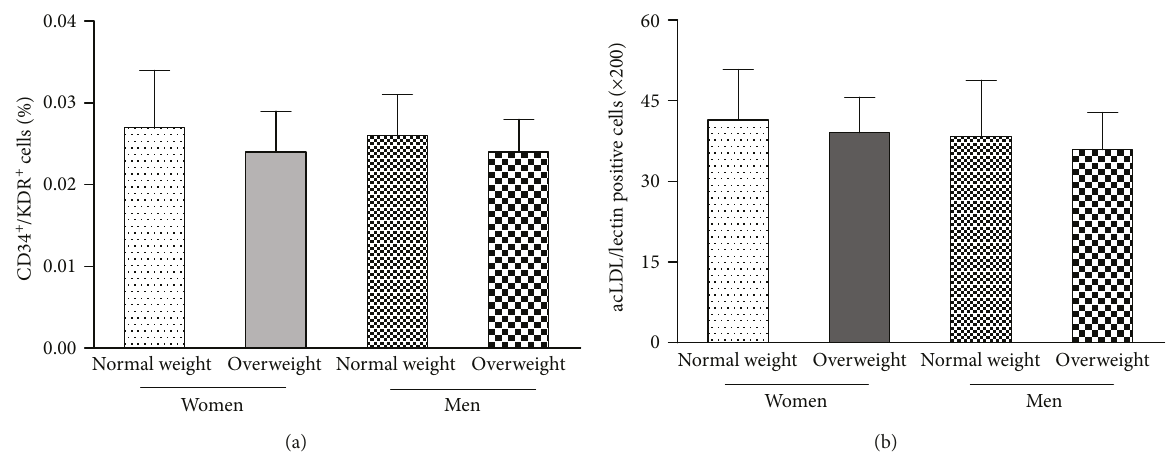
Figure 1: The number of circulating endothelial progenitor cells (EPCs) was evaluated as follows: by (a) fl uorescence-activated cell sorting analysis and (b) phase-contrast fl uorescent microscopy. The number of circulating EPCs in normal weight and overweight men was similar to that in normal weight and overweight postmenopausal women. The EPC number in overweight men and postmenopausal women was also similar to that in normal weight men and postmenopausal women. Data are given as the mean ± standard deviation (SD). ∗ p < 0 05 versus normal weight.